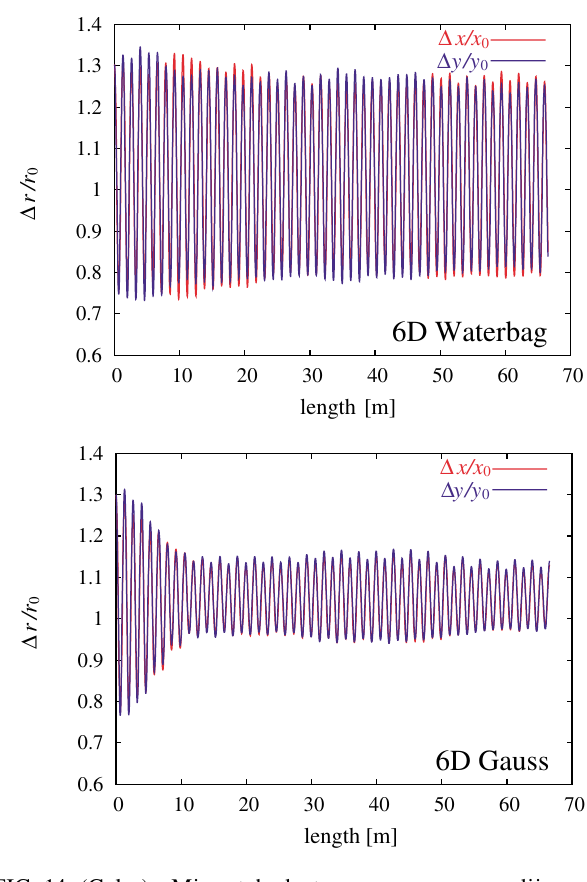
FIG. 14. (Color) Mismatched transverse core radii over matched core radii for 6D waterbag and Gauss, 200 focusing periods, and fast mode excitation.